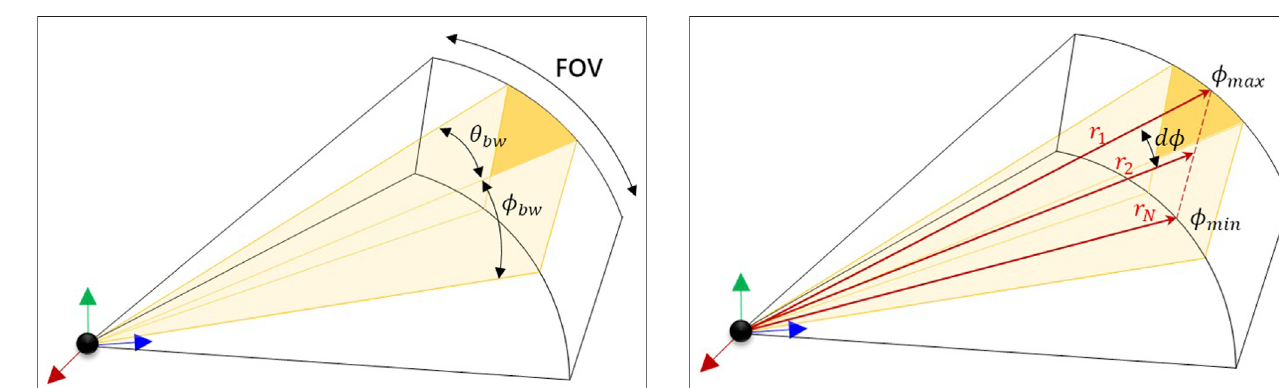
( Figure 3 ). (cid:129) The re fl ectivity of the target intersected by the i -th ray, μ which is a property of the target object model (shape, size, and material), and the sonar frequency and bandwidth.